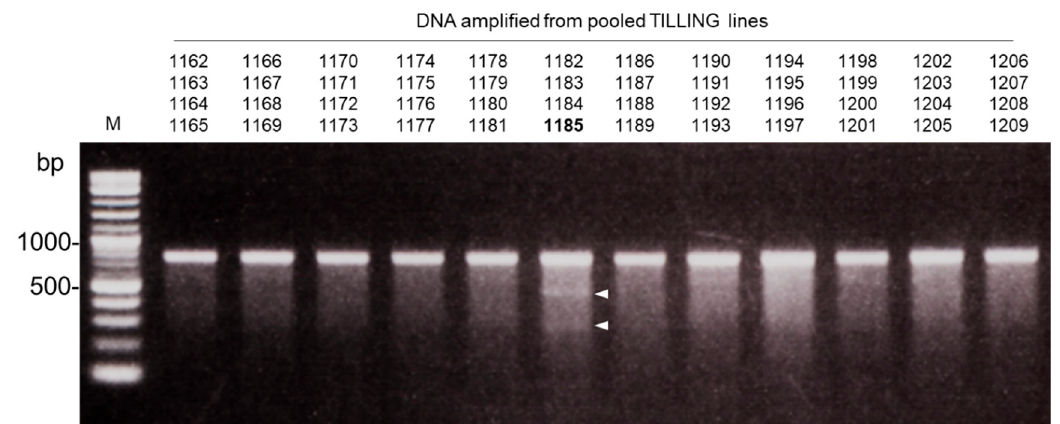
Figure 3. Expression of recombinant CELI protein by an agrobacterium-based transient expression in Nicotiana benthamiana . ( A ) SDS-PAGE analysis of the recombinant CELI protein extracted from the leaves after 5 d of agroinfiltration. ( B ) The affinity purification of CELI-6xHis protein using a nickel column.